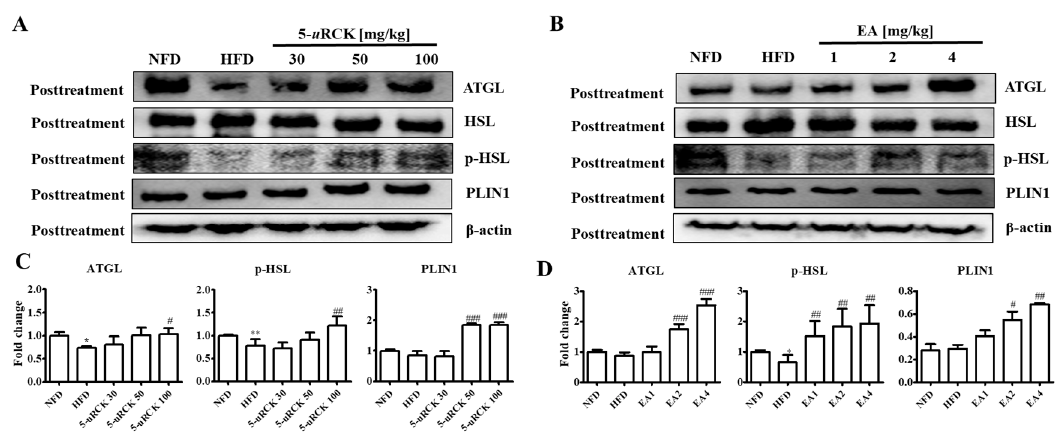
Figure 7. E ff ect of 5- u RCK and ellagic acid supplementation on lipolysis-associated protein in HFD-fed mouse visceral epididymal white adipose tissue (eWAT). E ff ects of 5- u RCK ( A ) and ellagic acid ( B ) on adipose triglyceride lipase (ATGL), hormone-sensitive lipase (HSL), phosphorylated hormone-sensitive lipase (p-HSL), and perilipin1 (PLIN1) expression in eWAT and assessed by western blot analysis. Each value ( C , D ) was normalized to β -actin and expressed as the mean ± SD. The levels of p-HSL (Ser563) proteins were normalized to HSL and expressed as the mean ± SD. P values for comparisons with control groups (NFD groups) are denoted as * p < 0.05 and ** p < 0.01, and those for comparisons with HFD groups are denoted as # p < 0.05, ## p < 0.01, and ### p < 0.001.